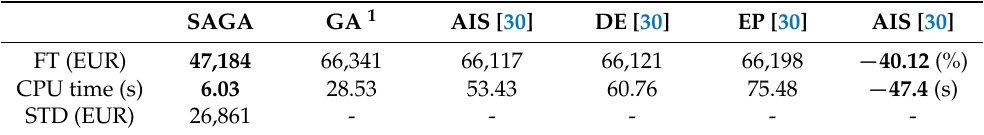
Table 2. Optimal generation scheduling of the test system